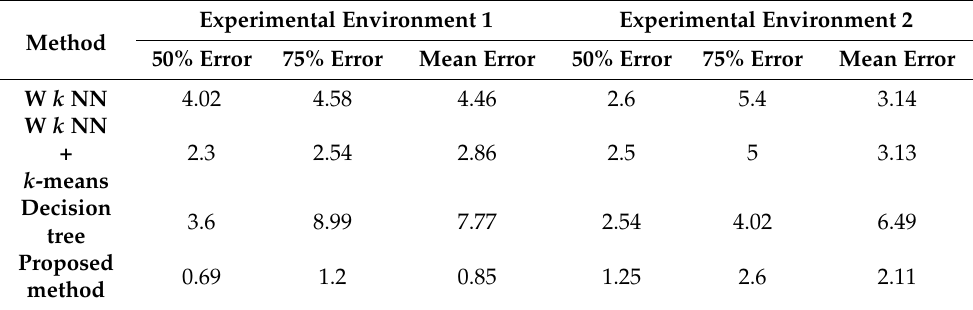
Table 4. Comparison of error statistics of the traditional algorithms and proposed